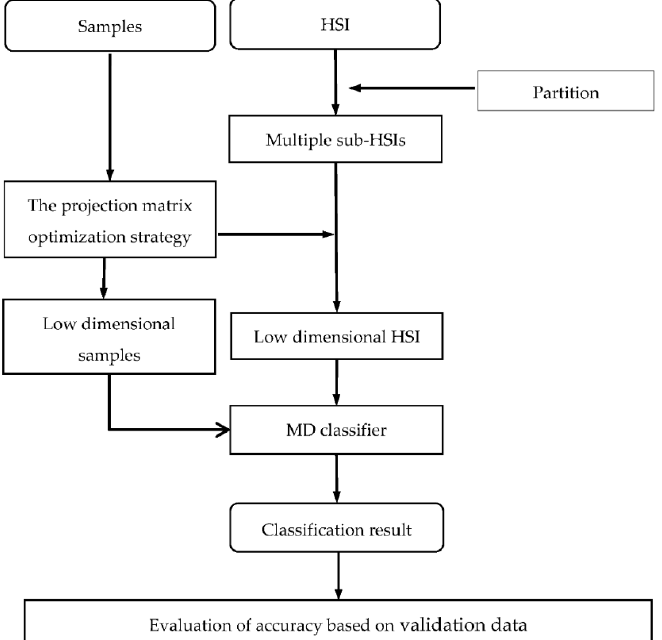
Figure 3. Flow chart of the proposed classification algorithm in this paper.